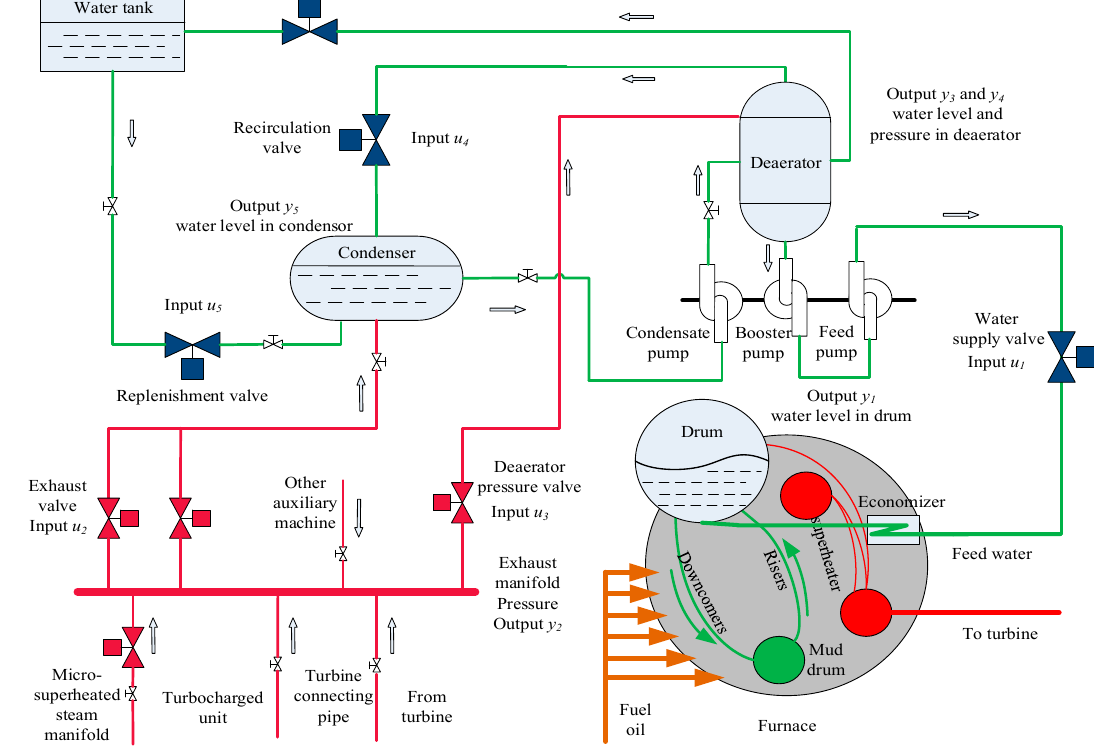
Figure 1. Scheme of complete steam/water loop investigated in this paper.